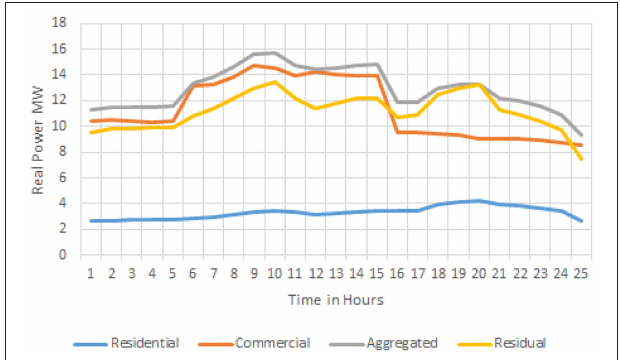
FIGURE 3 | Generation profiles—customers.